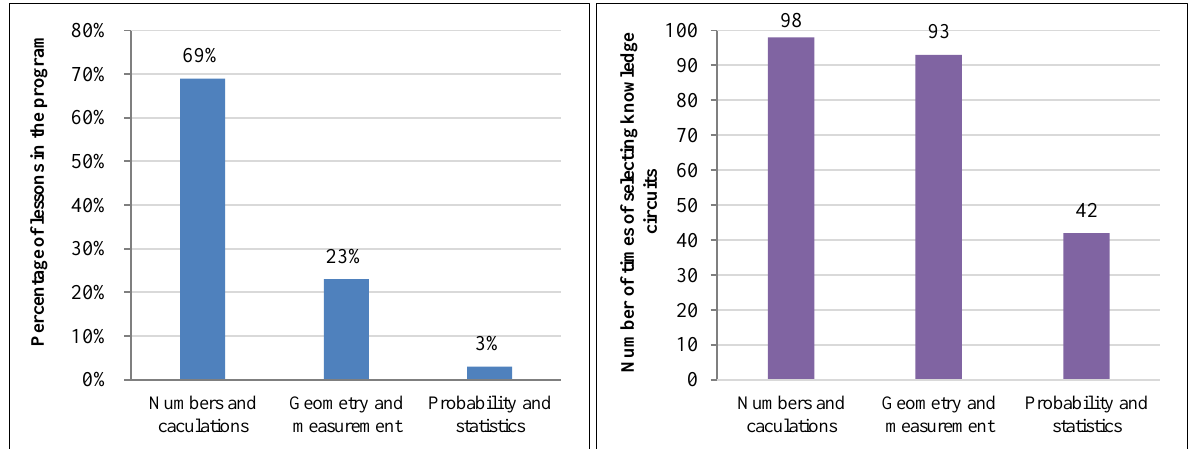
Figure 3. The probability of using idioms and proverbs in teaching knowledge circuits of